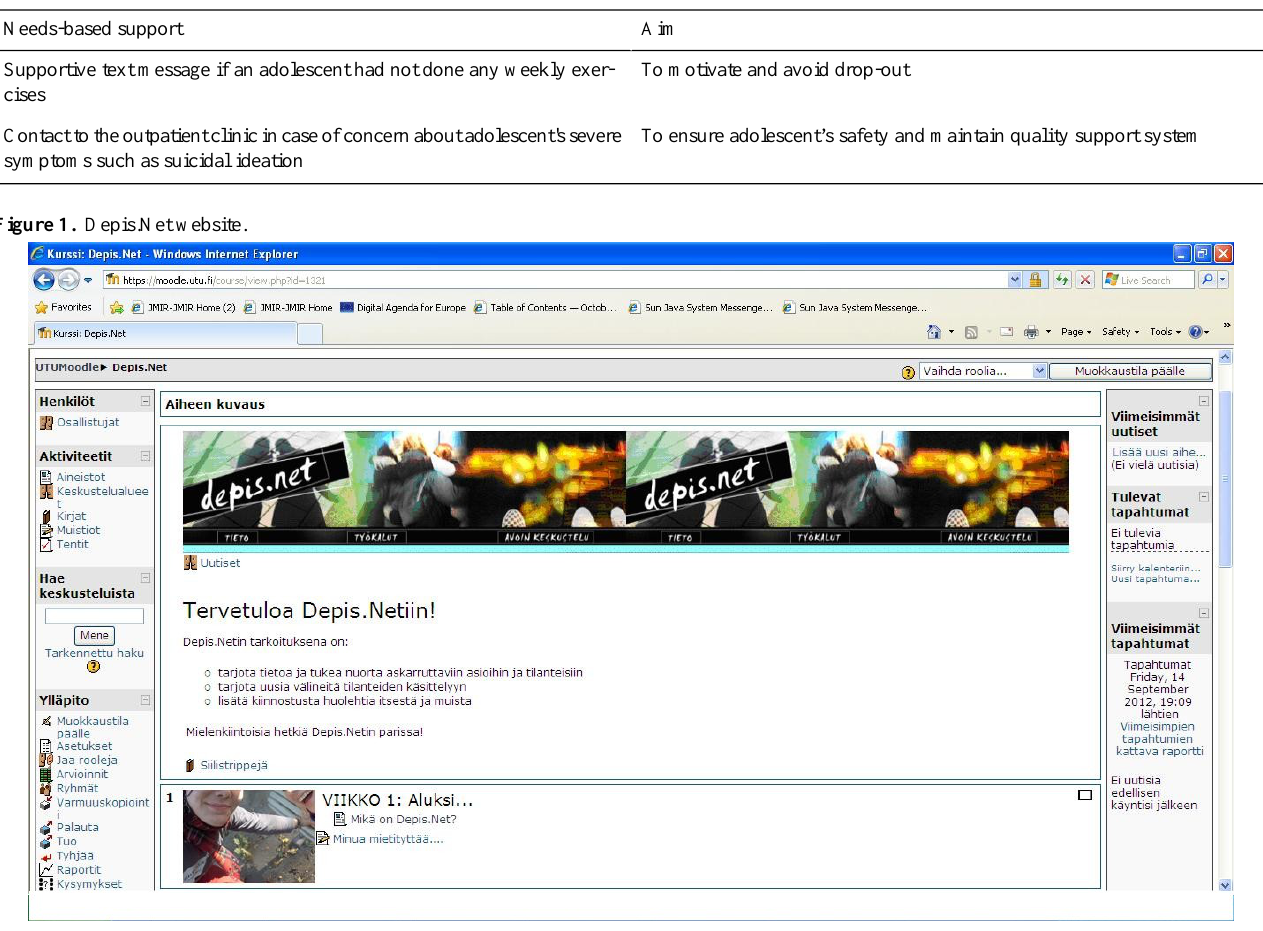
Table 4. Need-based support provided in the Internet-based support system.